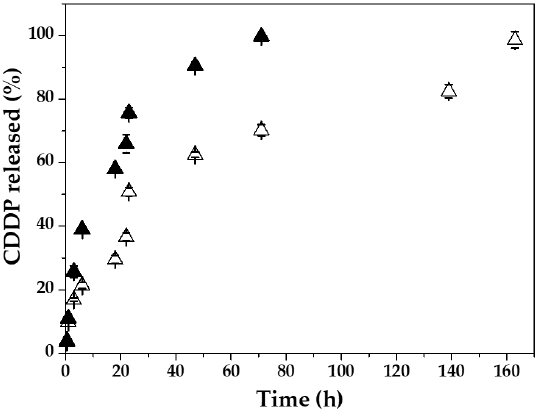
Figure 7. In-vitro release of CDDP (%) from the ( γ -Fe 2 O 3 /PLGA)/CS (core/shell)/shell NPs as a function of the incubation time (h) at 37.0 ± 0.5 °C, and pH 7.4 ± 0.1 ( Δ ) or pH 5.0 ± 0.1 ( ▲ ). Data is function of the incubation time (h) at 37.0 ± 0.5 ◦ C, and pH 7.4 ± 0.1 ( ∆ ) or pH 5.0 ± 0.1 ( (cid:78) ). Data is presented as mean value ± SD ( n = 3). presented as mean value ± SD ( n =